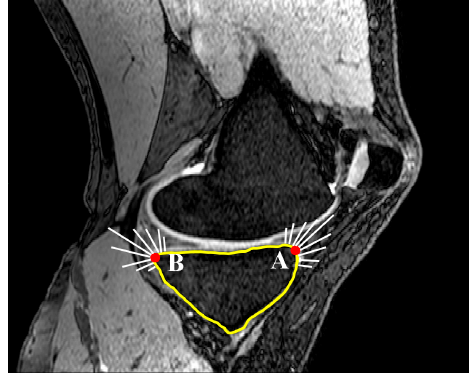
Figure 4. Locating nodes A and B based on Gaussian curvature analysis for each MRI slice (sagittal view).